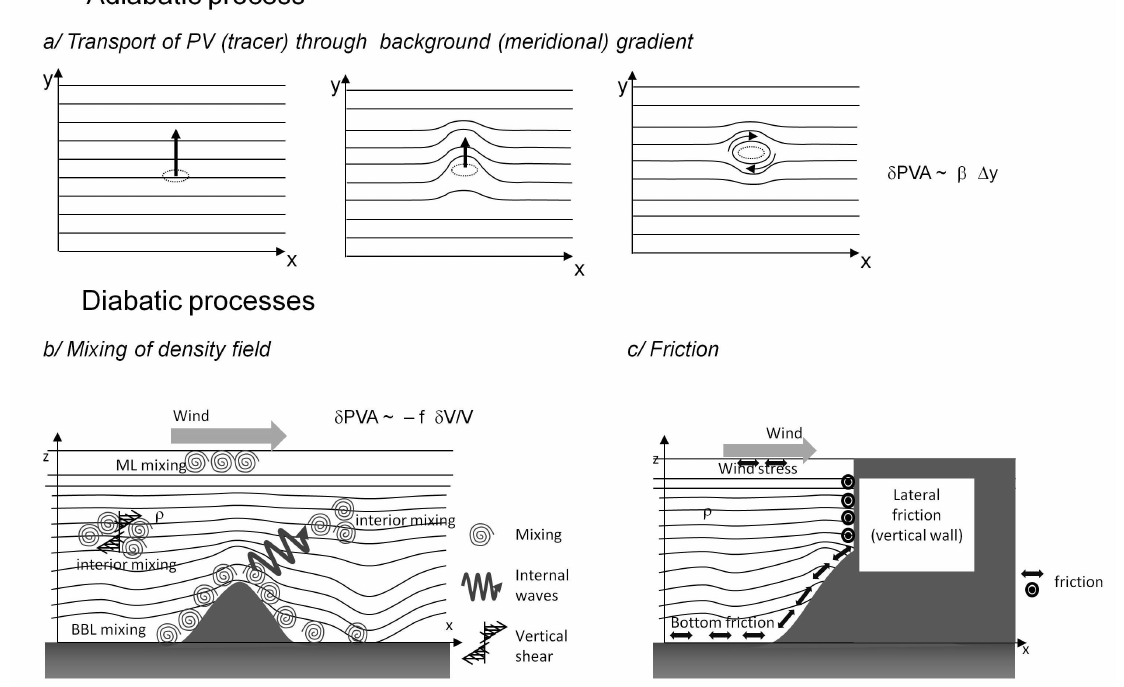
Figure 12. Illustration of the main mechanisms for the formation of PV anomalies and vortical structures. Adiabatic meridional advection generates PV anomalies when a particle is displaced within a background PV gradient ( a ). Diabatic mechanisms are associated with diapycnal mixing ( b ) or friction close to boundaries ( c